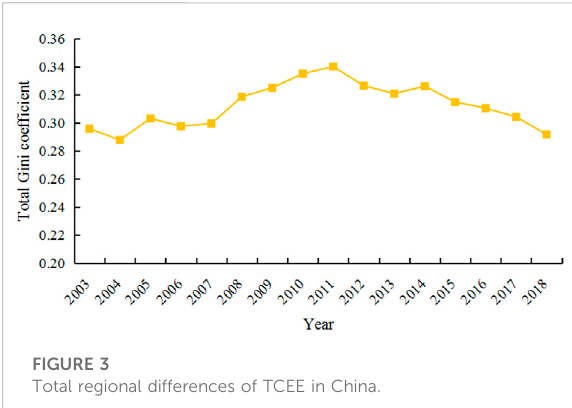
Table 3. In order to make the results more intuitive, we visualized the results (Figures. 3 – 6).